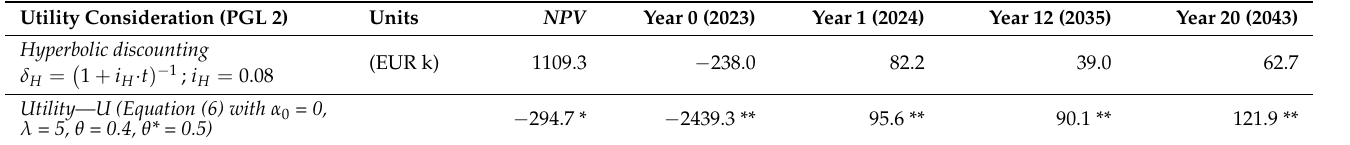
Table 4. Application of the power curve to consider diminishing sensitivity and loss